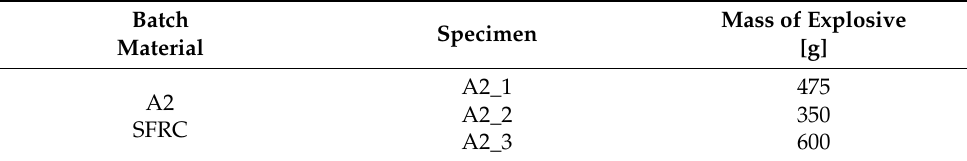
Table 5. Load weight values for field tests of SFRC